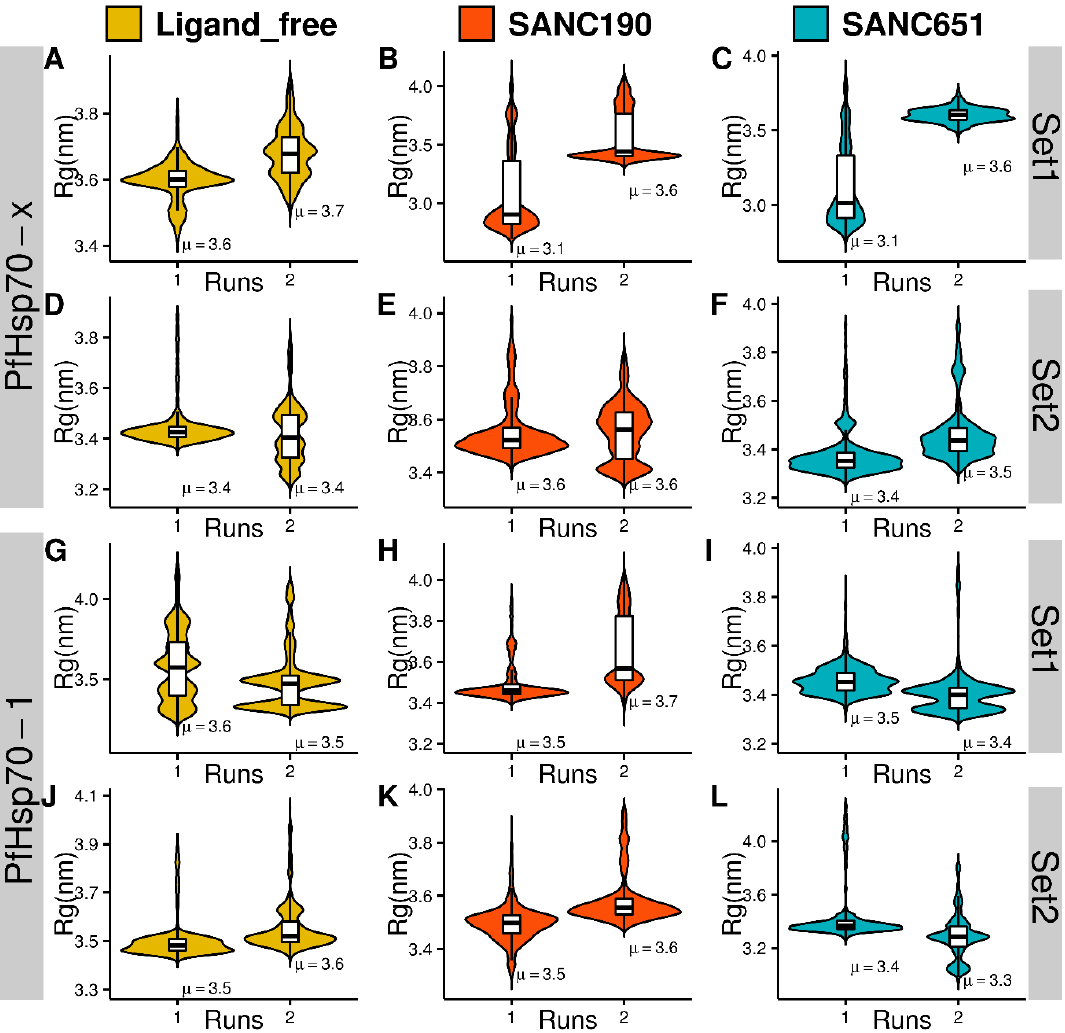
Figure 5. Kernel density estimation plots of the radius gyration (Rg). Comparisons of structural compactness between ligand-free and ligand-bound PfHsp70-x and PfHsp70-1. ( A – L ) The RMSD violin plotting scheme was employed in plotting the Rg figure as well.